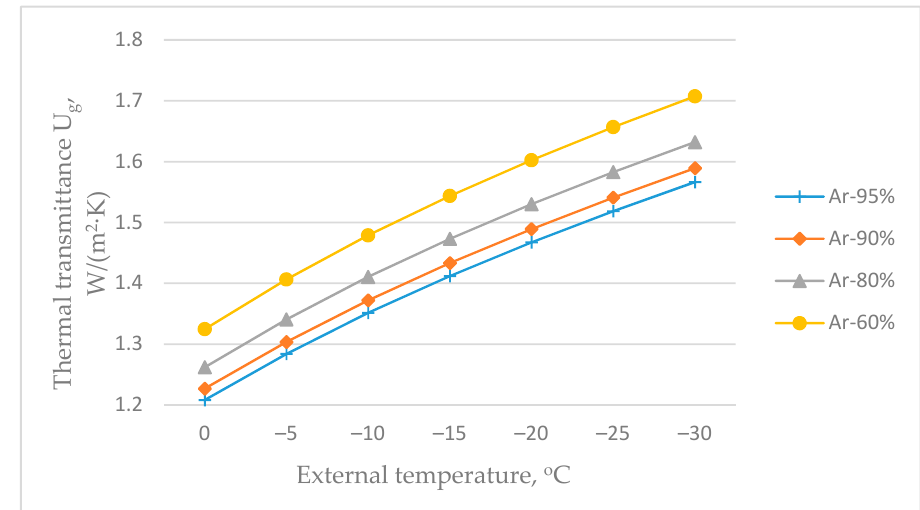
Figure 5. Dependence of the U g -value of a double-glazed IGU with a distance of 16 mm between the panes on the concentration of the argon gas fill and external air temperature. The results of the calculations of dependencies of the thermal transmittance (U g , W/(m 2 ·K)) values of the central part of the triple-pane IGU on external air temperature and Low-E coating corrected emissivity value ε , when the distance between glass panes was 16 mm and the argon gas fill concentration was 95%, are presented in Figure 6. Figure 6. Dependence of the U g -values of the triple-glazed IGU on the Low-E coating value and external air temperature. The graphs from Figure 6 show that the thermal transmittance increases rapidly with the change in the external air temperature from 0 ° C (standard temperature) to − 30 ° C (design temperature for the calculation of peak heating power in Lithuania for lightweight